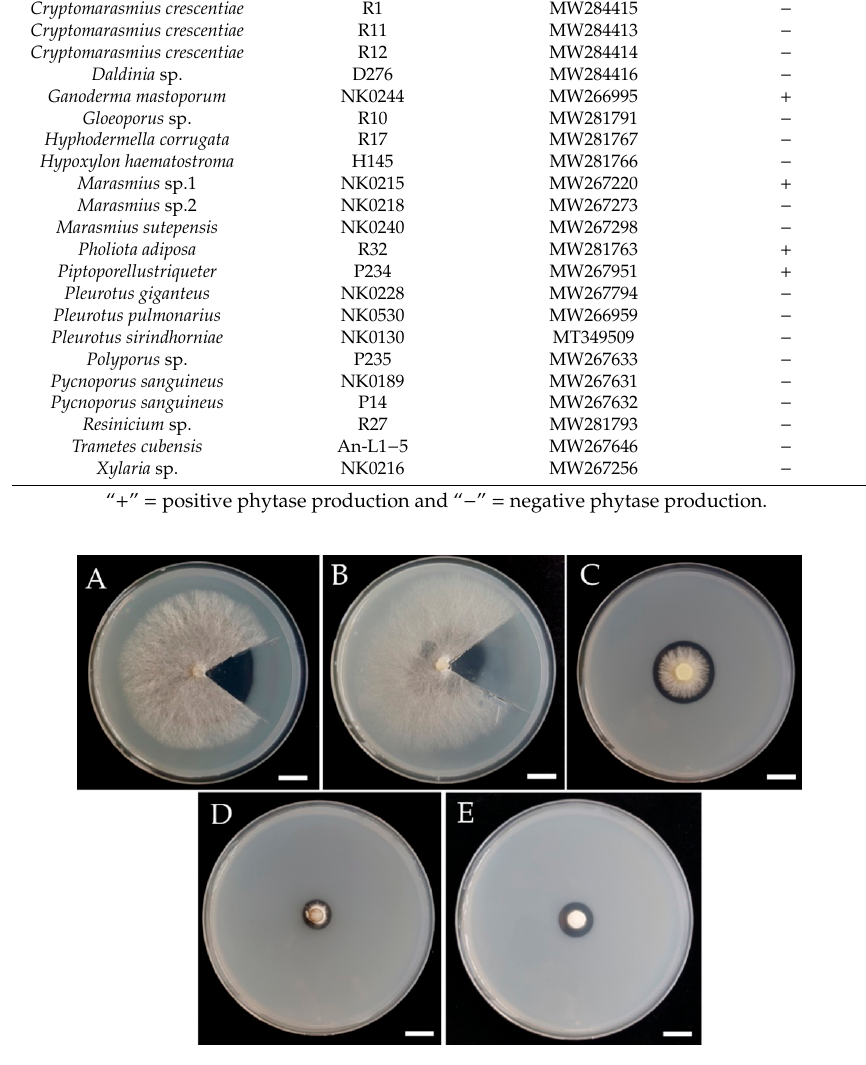
Figure 1. Clear zone of phytase production on PSA. ( A ) P. adiposa , ( B ) G. mastoporum , ( C ) Pi. triqueter , ( D ) Am. rugosum , ( E ) Marasmius sp.1 Scale bar: 10 mm. Five selected mushroom strains were fermented with five different agricultural residues for phytase production under SSF. It was found that the phytase production of each selected mushroom strain was significantly affected by the agricultural residue that was used. The highest phytase activity of 17.02 ± 1.13 U/gds was achieved with water hyacinth fermented with P. adiposa , followed by oil palm empty fruit bunch fermented with Am. rugosum (8.28 ± 0.26 U/gds), and coffee parchment fermented with Am. rugosum (7.81 ± 0.28 U/gds) (Figure 2). Notably, the lowest phytase activity was obtained from coffee parchment fermented with Marasmius sp.1 (0.28 ± 0.05 U/gds). On the basis of the highest phytase activity, P. adiposa was selected for further investigation. 3.2. Effect of Carbon and Nitrogen Sources in Basal Liquid Medium for Phytase Production This experiment was performed to examine suitable carbon and nitrogen sources of the basal liquid medium for phytase production from P. adiposa under SSF. Water hyacinth was used as a substrate based on the suitable substrate for its phytase production. The results revealed that the highest degree of phytase activity was found in glucose at an average of 23.24 ± 0.37 U/gds, followed by fructose (22.68 ± 0.66 U/gds), maltose (20.07 ± 2.15 U/gds), and starch (19.83 ± 1.17 U/gds) (Figure 3A). The basal liquid medium containing glucose was replaced with different organic and inorganic nitrogen sources. The highest phytase activity was obtained from ammonium nitrate at 24.48 ± 0.3 U/gds, followed by peptone (17.66 ± 0.63 U/gds), and ammonium sulfate (17.04 ± 1.48 U/gds), whereas the lowest phytase activity was found in malt extract (9.42 ± 0.87 U/gds) (Figure 3B). Therefore, glucose and ammonium nitrate were selected and used in the basal liquid medium for further experimentation.